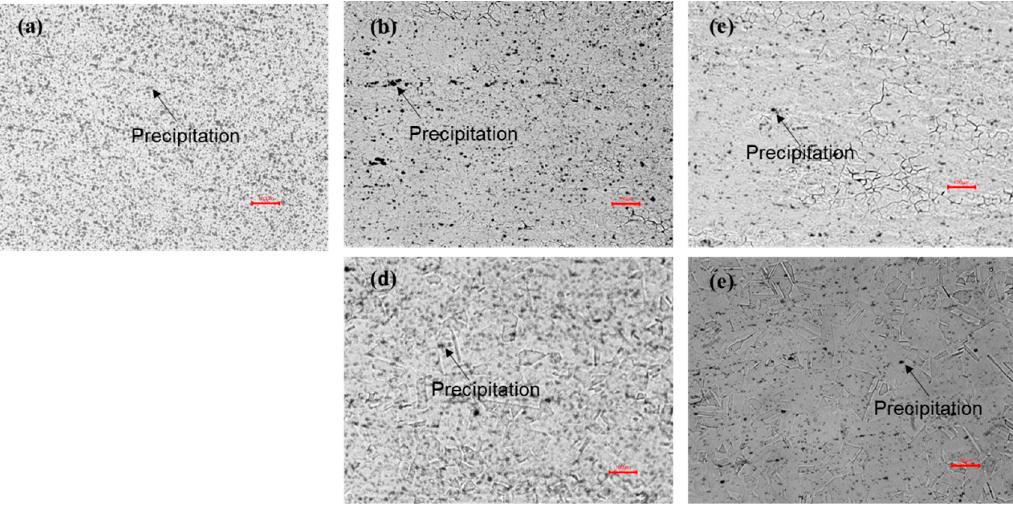
Figure 3. Microstructures of 253 MA ASS after ( a ) cold rolling and then ( b ) annealing at 1100 °C with annealing times of ( c ) 900; ( d ) 1800; ( e ) 3600 s with 100× magnification. annealing times of ( c ) 900; ( d ) 1800; ( e ) 3600 s with 100 ×